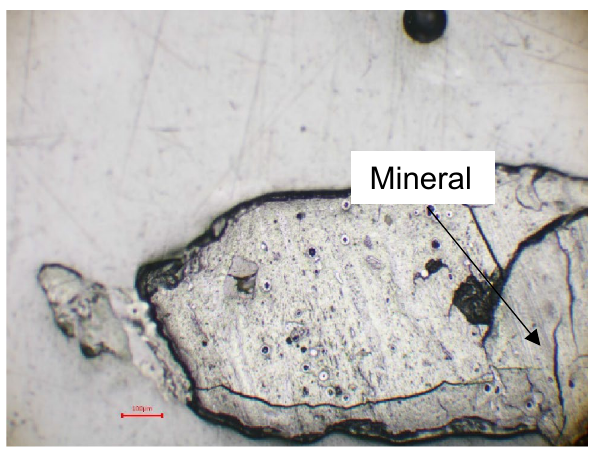
Fig. 14 Mineral on coal sample under white